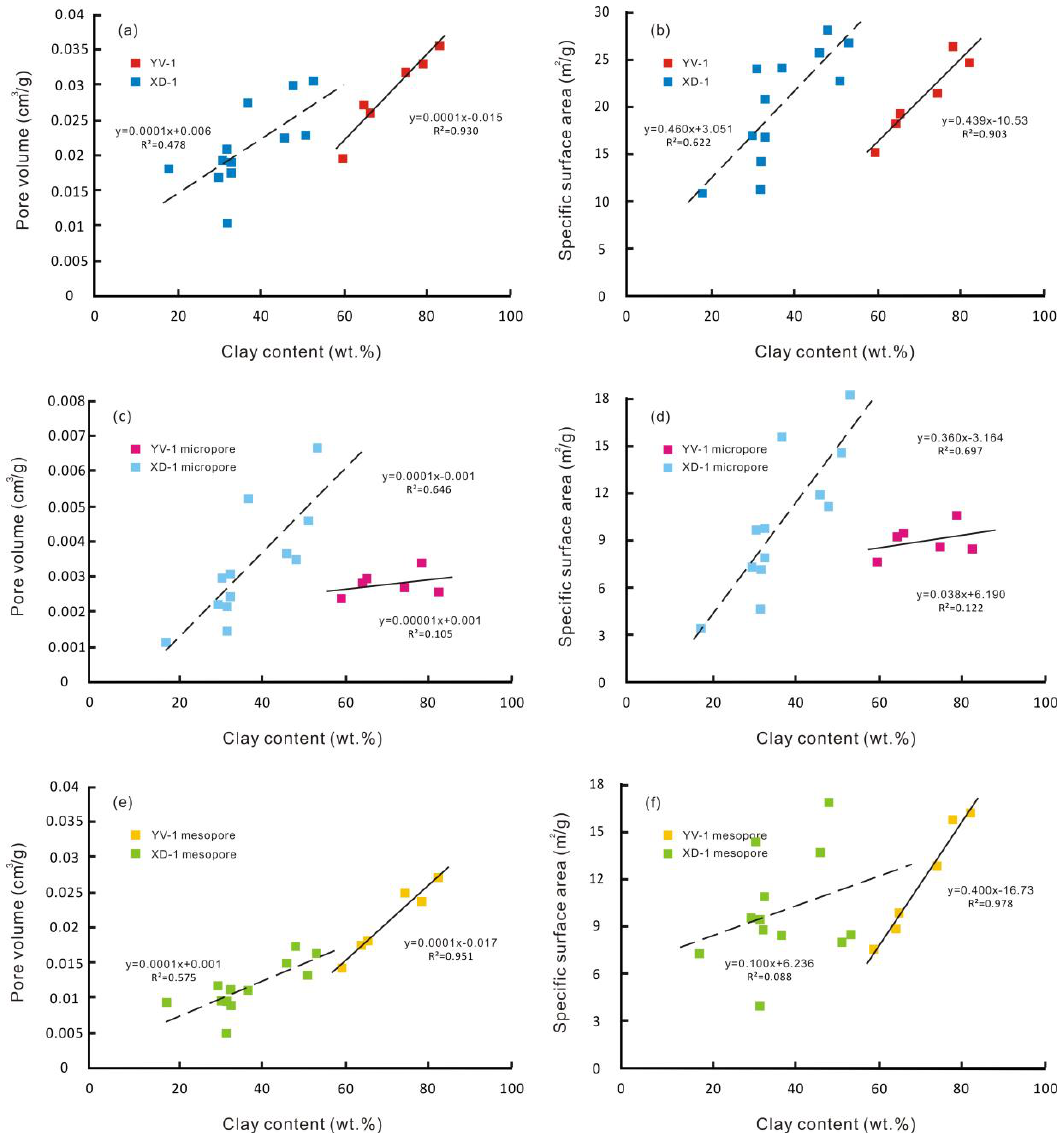
Figure 15. Relationships between clays content and PV ( a ), SSA ( b ), micro-PV ( c ), micro-SSA ( d ), meso-PV ( e ), meso-SSA ( f ) of transitional Longtan Shale samples from YV-1 and